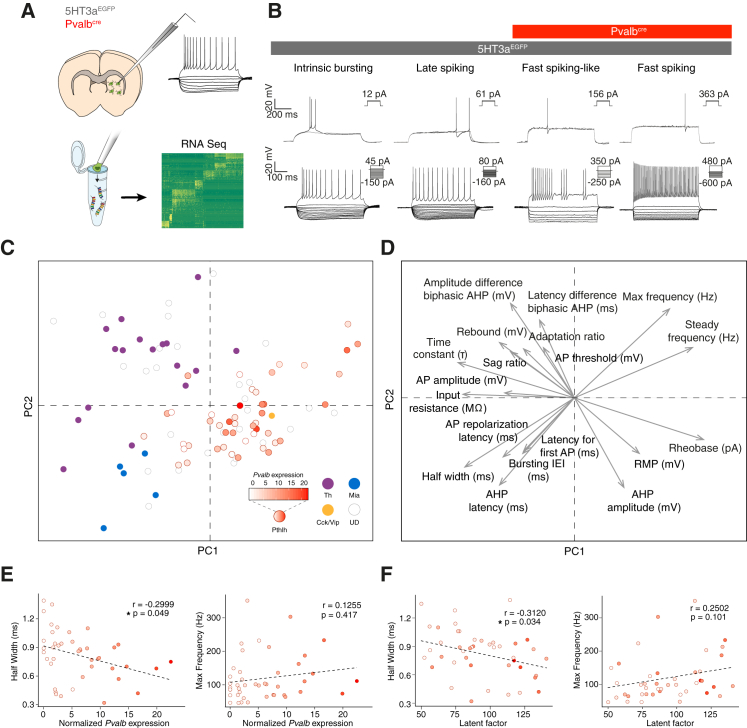
Electrophysiological Properties within the Pthlh Population Revealed Using PatchSeq(A) Schematic of the PatchSeq protocol.(B) Representative traces of electrophysiological subtypes detected in the mouse lines used for the recordings.(C) Principal-component analysis (PCA) based on 19 electrophysiological parameters from 98 interneurons. The color of the dots refers to the molecular identity acquired by mapping them onto BackSPIN clustering of dataset B.(D) Vector factor map analysis showing how (arrow size) the parameters contribute to (A).(E) Correlations of AP half-width and maximum frequency with normalized Pvalb expression within the Pthlh population.(F) Correlations of AP half-width and maximum frequency with the Pthlh cell latent factor.See also Figures S4 and S5 and Table S3.